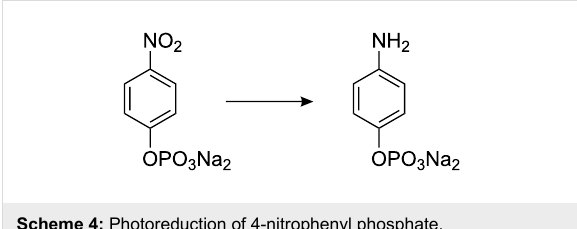
Scheme 4: Photoreduction of 4-nitrophenyl phosphate.